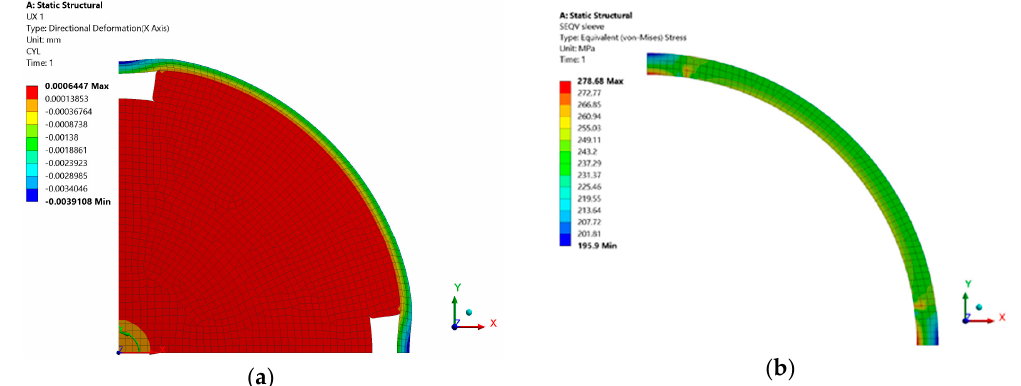
Figure 2. Radial displacements ( a ) and Von Mises stresses ( b ) in the sleeve material at 50,000 rpm.